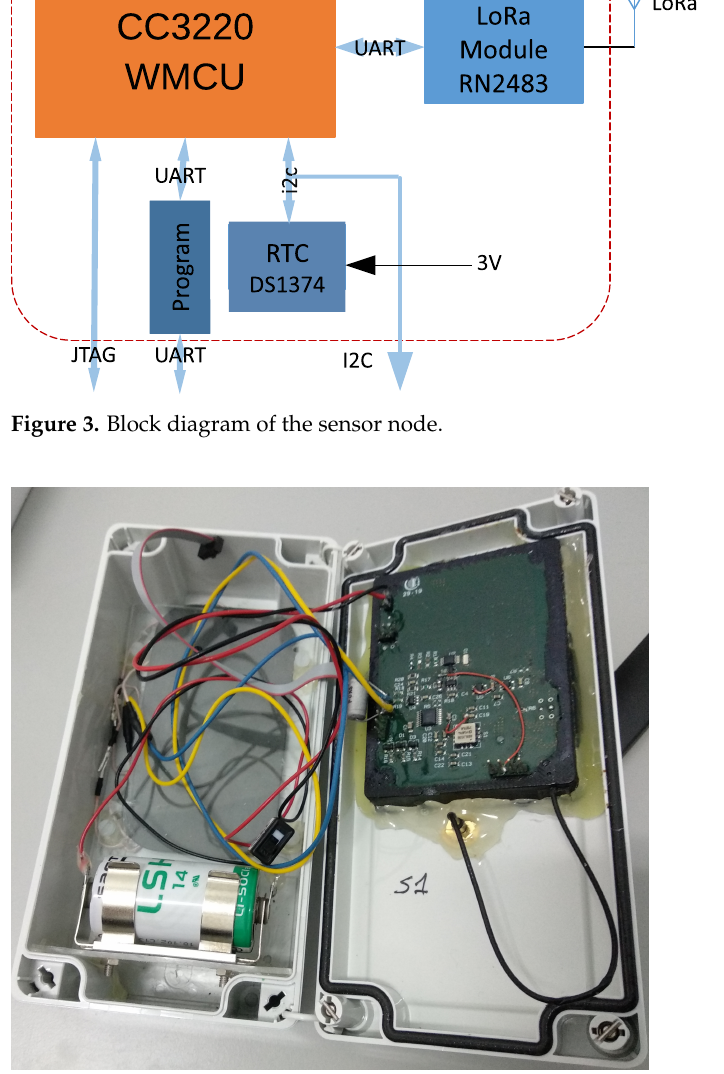
Figure 4. Sensor